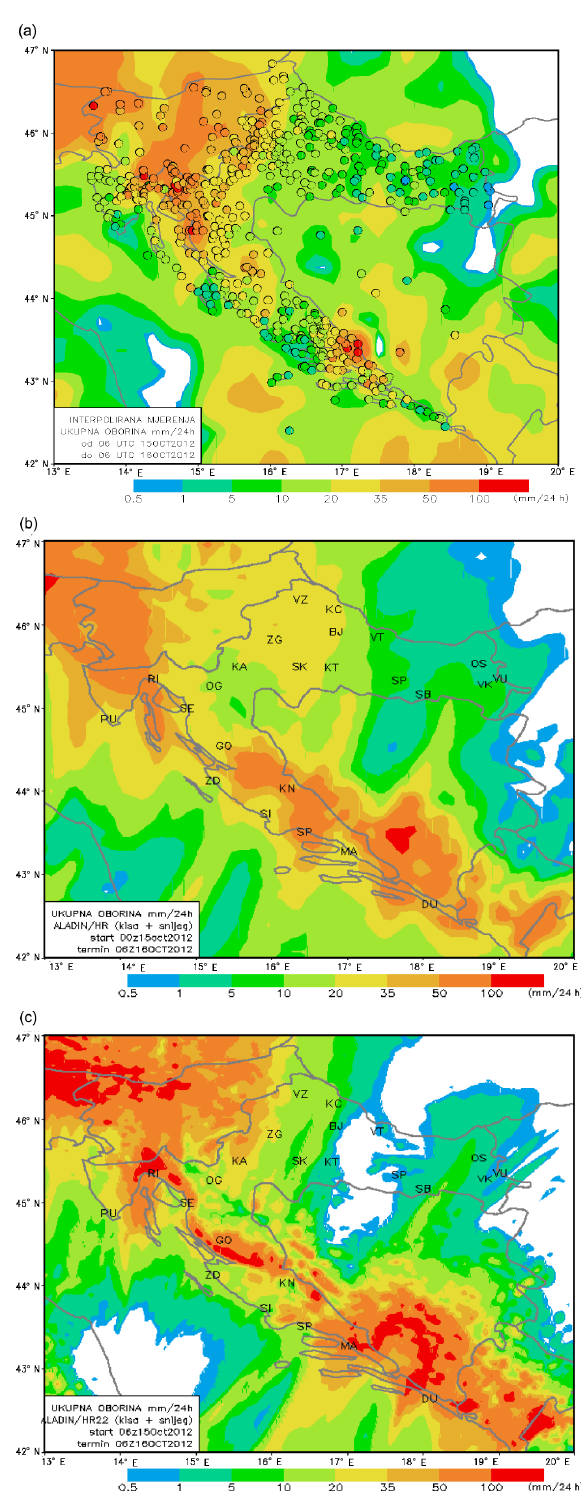
Figure 5. IOP13 (16 October): (a) accumulated 24h rainfall mea- sured on rain gauges (circles) and interpolated using data from rain gauges and the 3B42RT3 hourly product for periods starting at 06:00UTC; accumulated 24h precipitation forecasts (b) for the AL- ADIN 8km-resolution run (starting from 00:00UTC on the same day and (c) for the ALADIN 2km-resolution